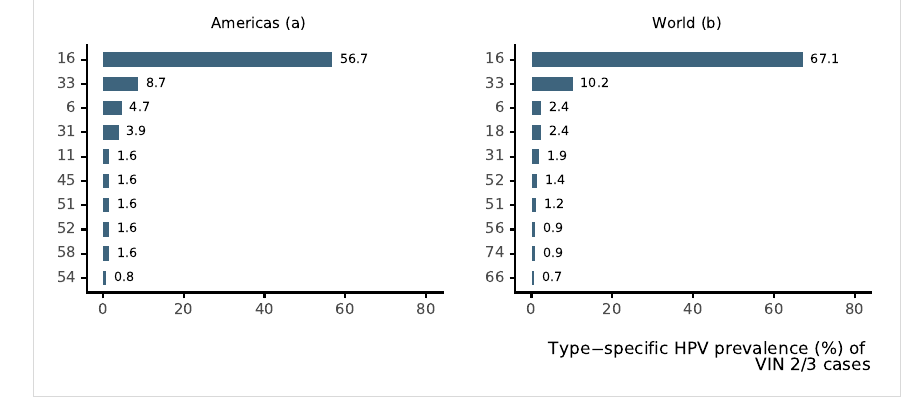
Figure 65: Comparison of the ten most frequent HPV types in VIN 2/3 cases in Americas and the